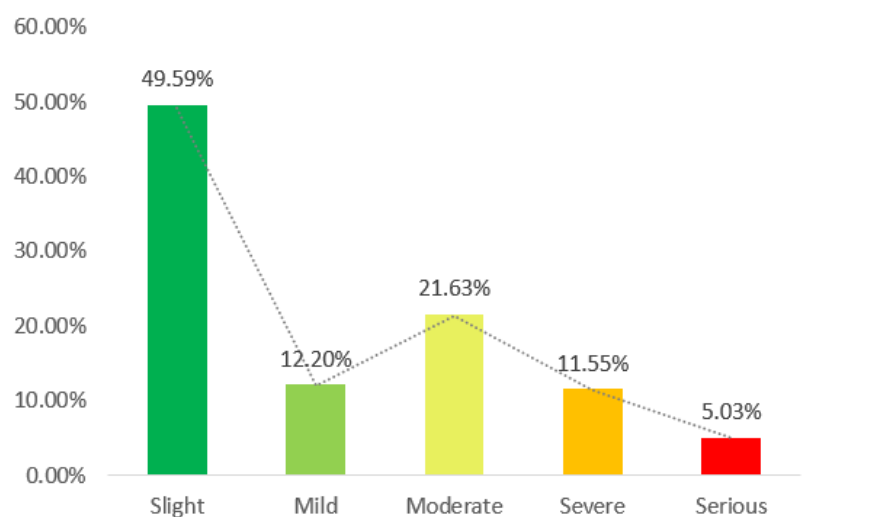
Figure 5. The proportion of the area disturbed by human activity.